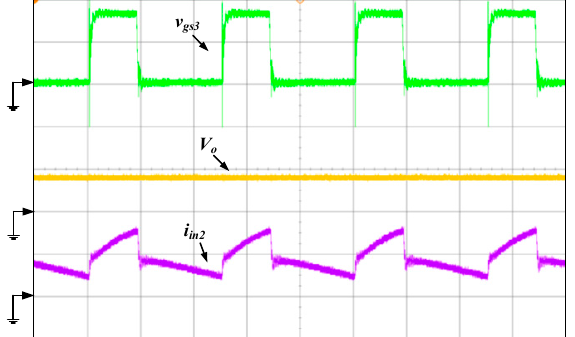
Figure 17. The measured waveforms of the control signal, output voltage, and input current while input 1 encounters power failure.